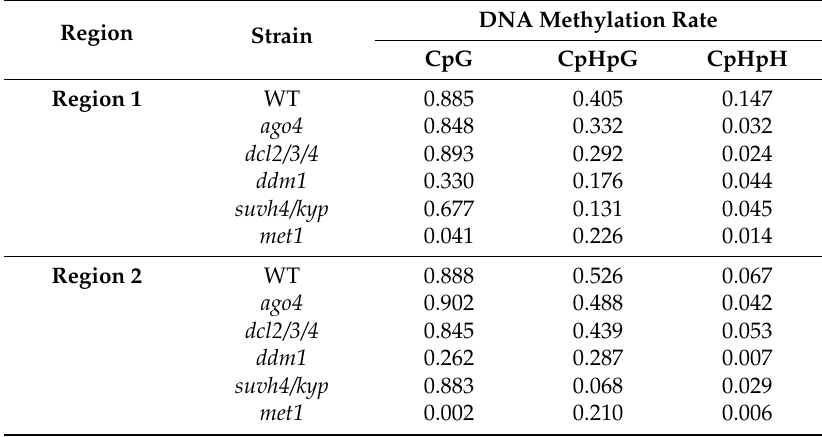
Table 3. Level of DNA methylation at mutants associated with epigenetic regulation. Region